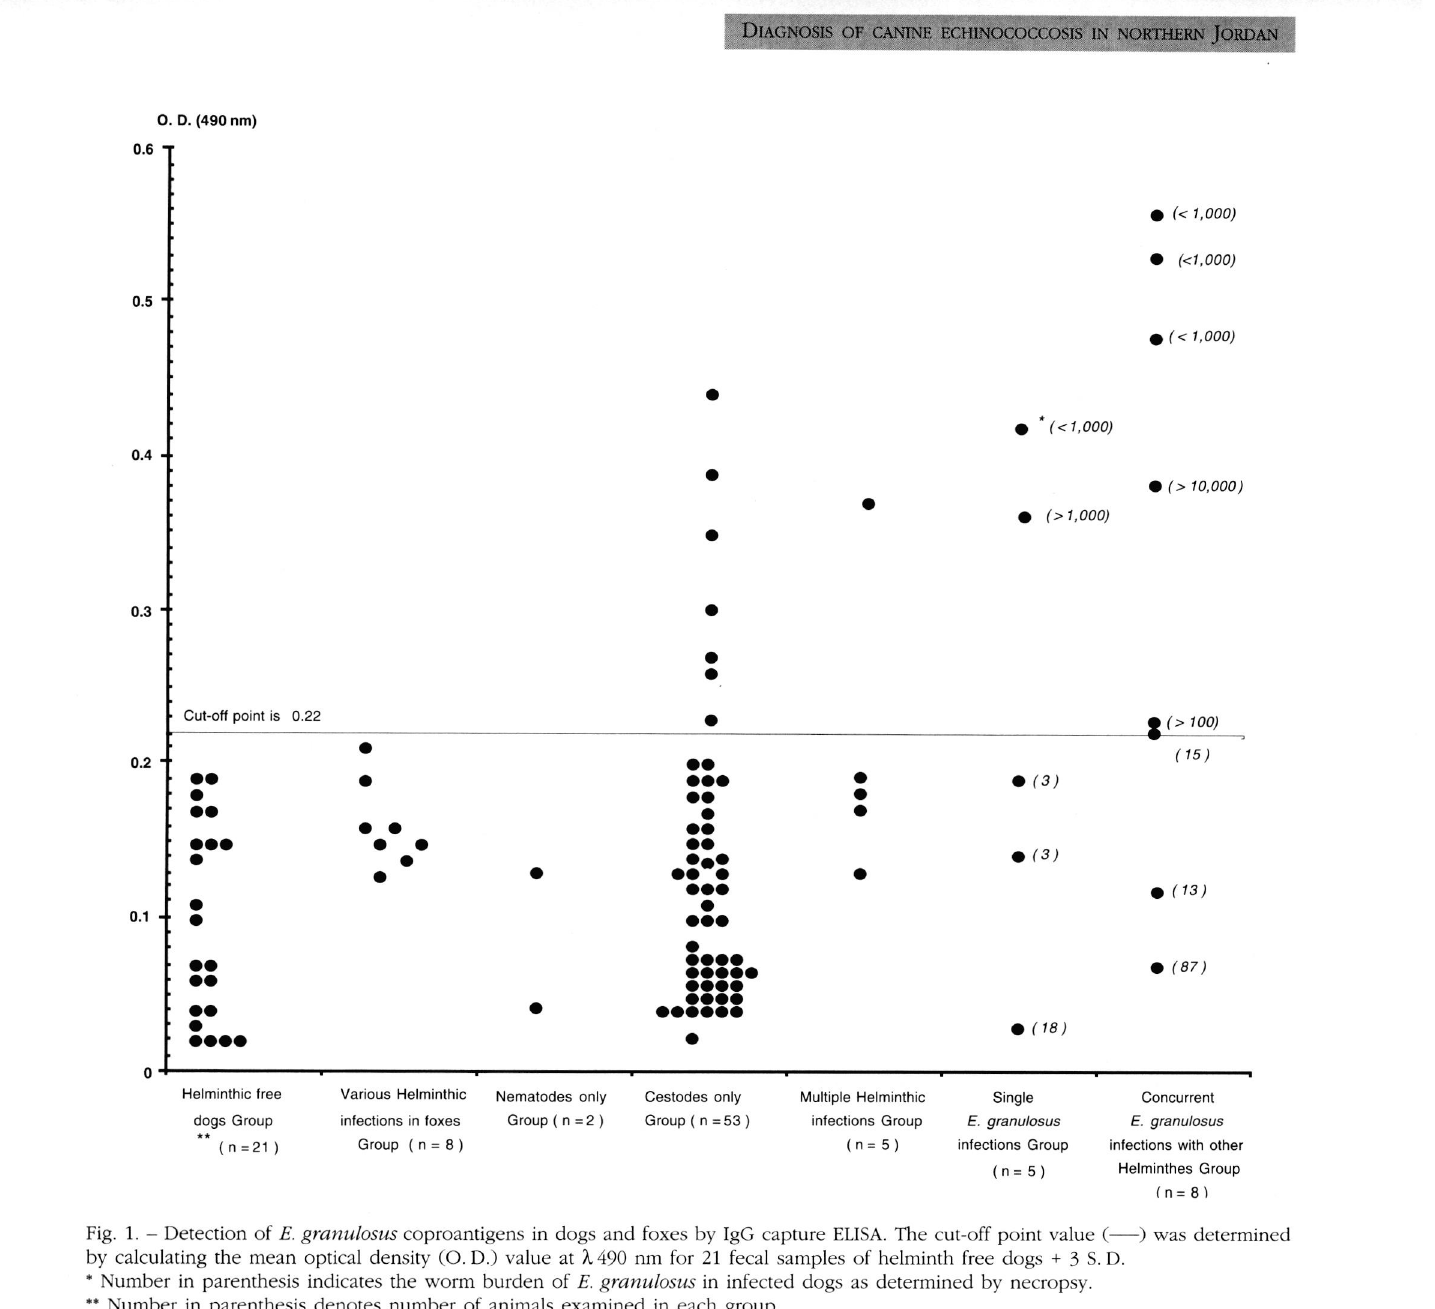
fetal calf serum (FCS) at 1:1 v/v ratio (Sigma, USA), and 100 pi of each sample was added per well and incubated for one hour at RT. After three washings, 100 pi of horseradish peroxidase (HRP) conjugated with anti EgACSA IgG at a dilution of 1:200 was added and incubated for one hour. After three washings, 100 pi of substrate solution consists of H citrate buffer, pH 4.5 containing ortho-phenyldiamine (OPD) chromogen (Sigma, USA) was incubated for 30 minutes at RT in dark. Finally, the optical density of each well was read at a wavelength of 490 nm using Micro-ELISA auto-reader (Dynatech, Virginia, USA). Positive control wells contained 5 pg/ml EgACSA